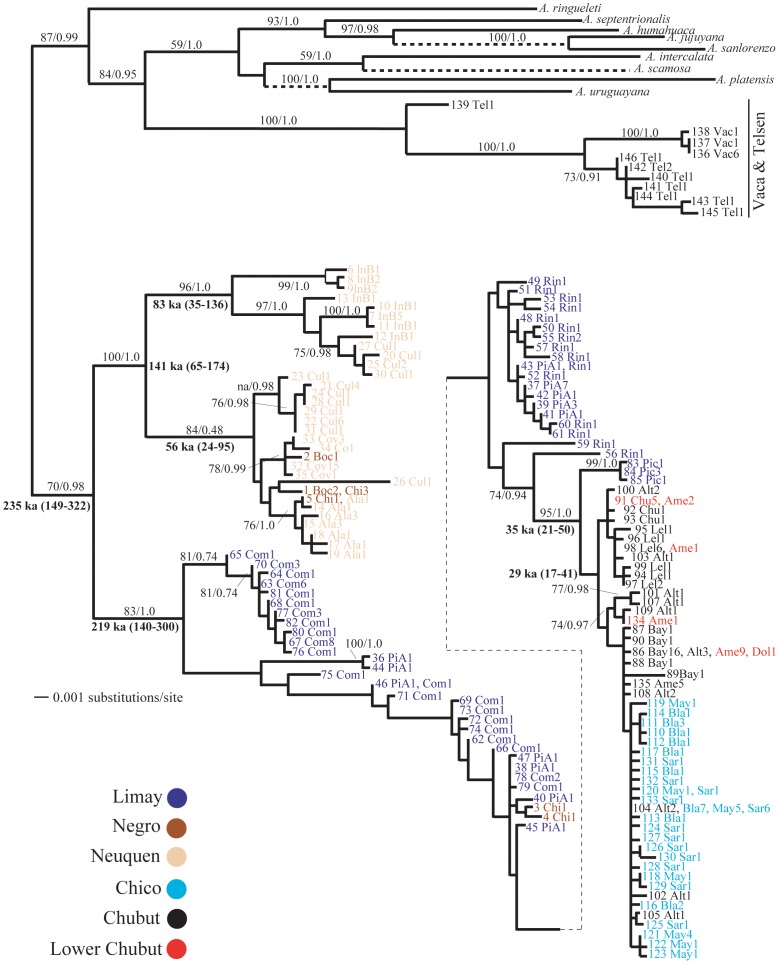
ML trees based on mtDNA haplotypes Aegla neuquensis.Numbers above branches are ML bootstrap supports (pre/) and Bayesian posterior probabilities (post/). Numbers in bold are estimates of the time of most recent common ancestor TMRCA [ka (95% HPD intervals)]. Dashed lines indicate outgroups with branches that were arbitrarily shorted to fit on page. Locality (see Table 1) and number of individuals are shown after that haplotype.